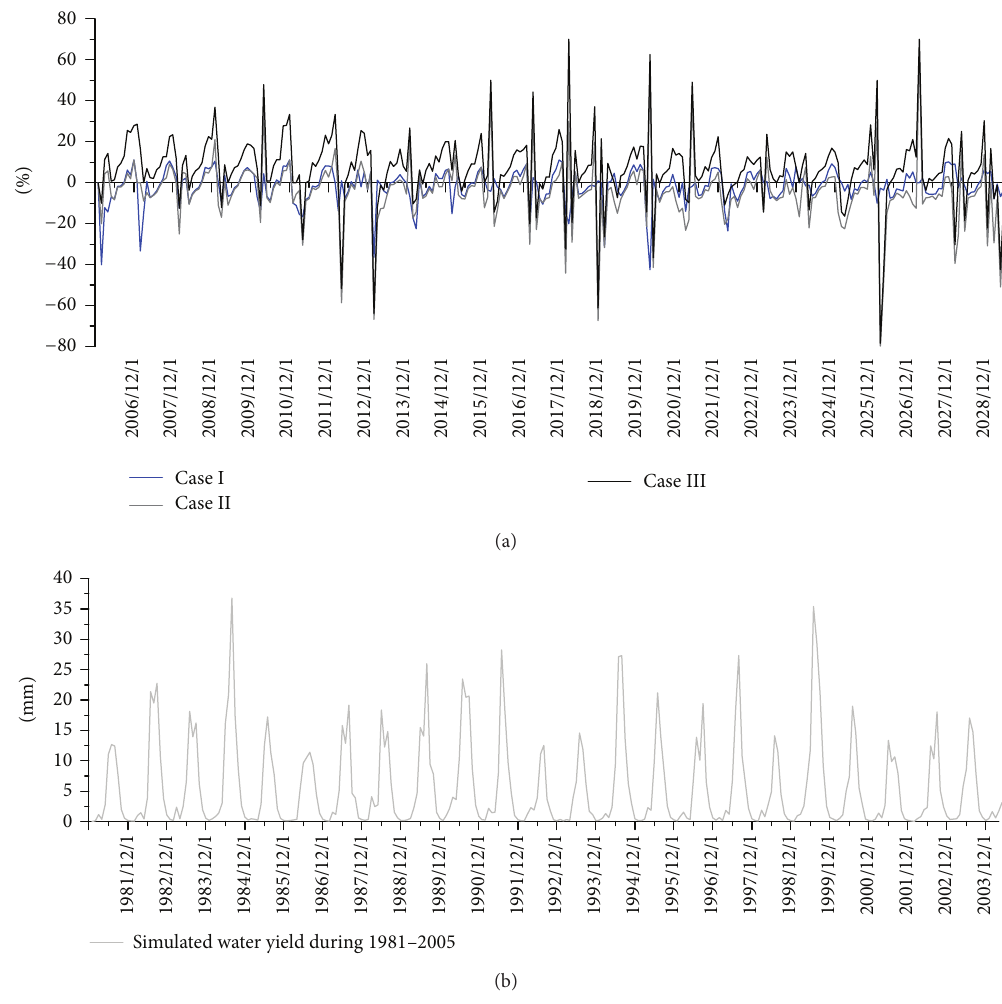
Figure 6: Comparison of water yields under three